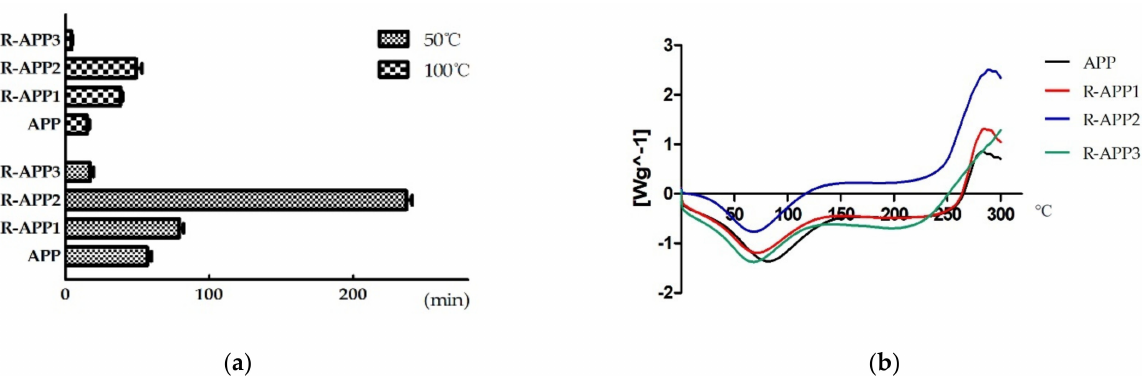
Figure 2. The dissolving time and DSC thermograms of APP and irradiated APP. ( a ) The dissolv- ing time of native APP and irradiated APP at the dose of 10 kGy (R-APP1), 100 kGy (R-APP2), and 1000 kGy (R-APP3); ( b ) the DSC curve of native APP and irradiated APP recorded over a temperature range of 0–300 ◦